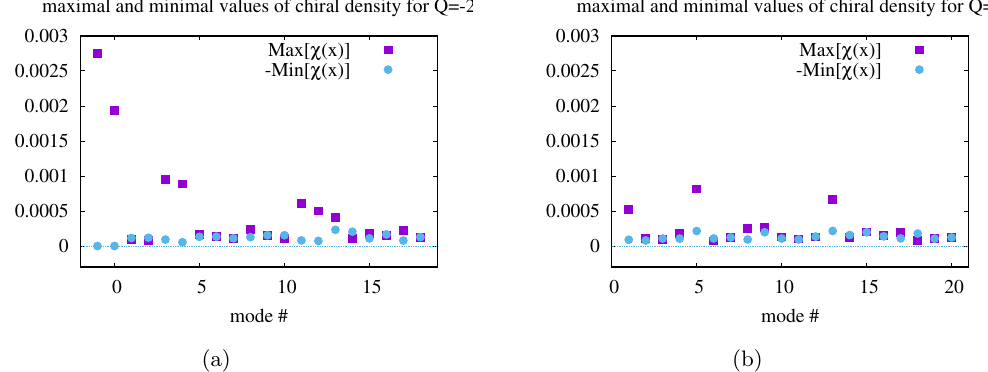
Figure 7 . Maximal and minimal values of the chiral densities of the 20 lowest modes for the above described con(cid:12)guration with Q = (cid:0) 2 (left) and Q = 0